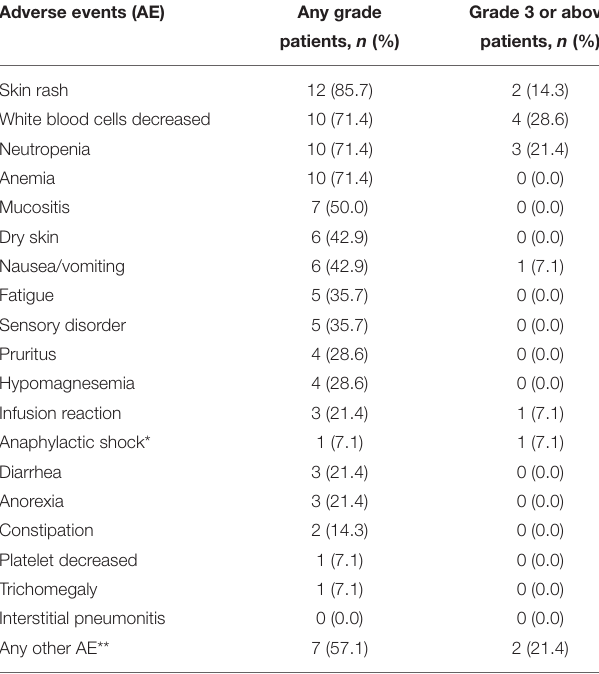
TABLE 3 | Adverse events. TABLE 4 | Subsequent